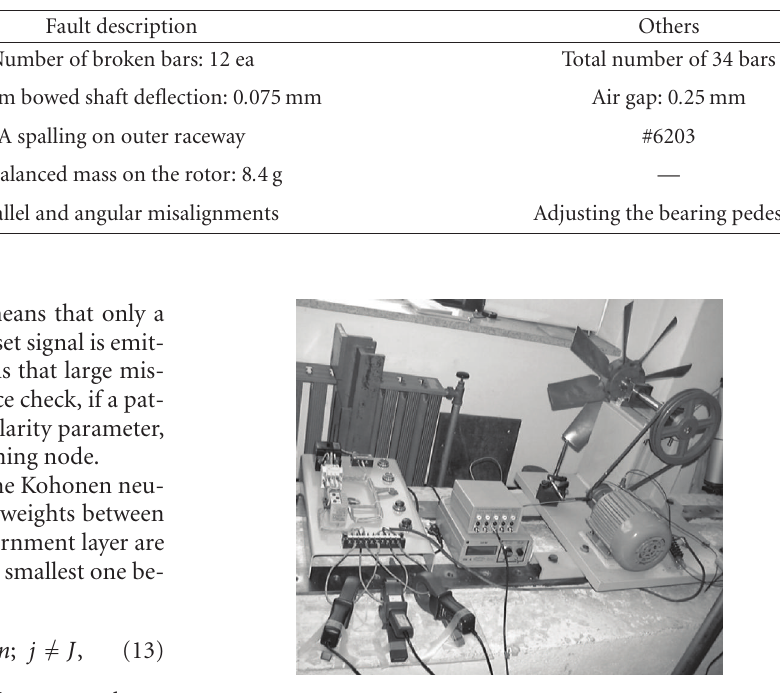
Figure 4: Experiment